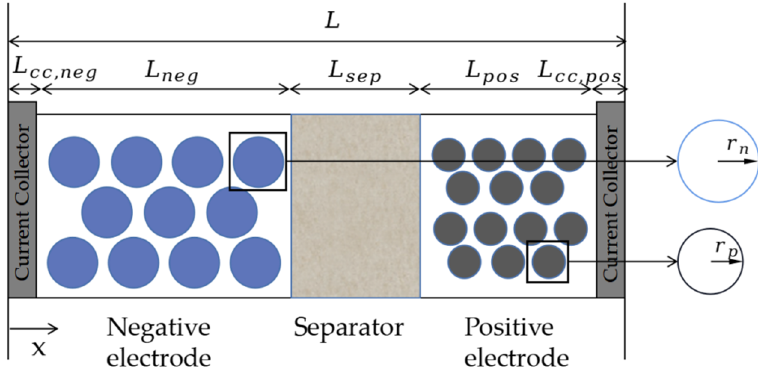
Figure 1. Illustration of the pseudo-two-dimension electrochemical model.